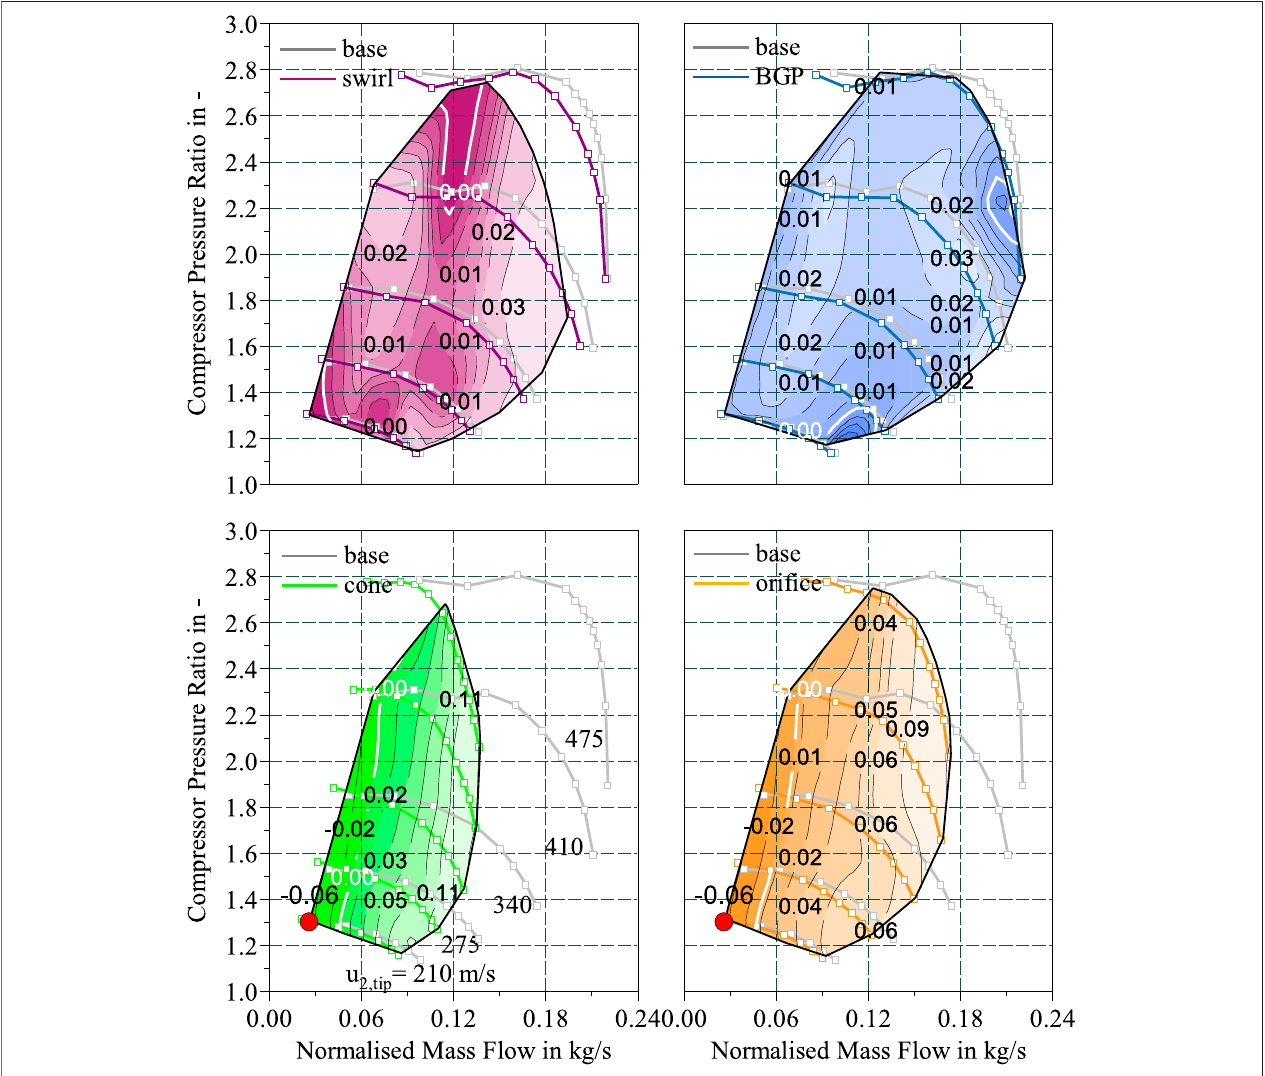
FIGURE 11 | Compressor performance maps for different geometrical